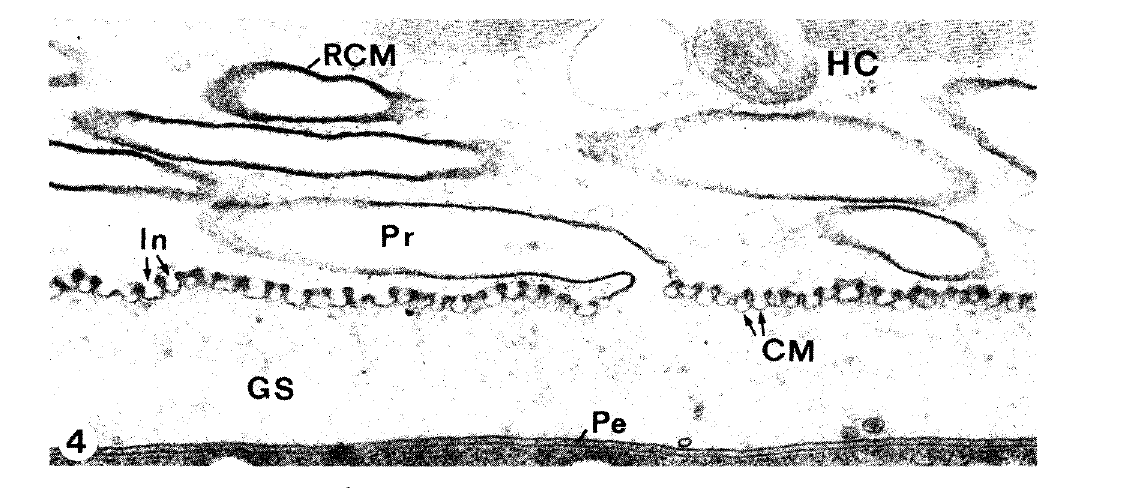
Fig. 4. Vertical section through the cyst wall, showing closely spaced vesicular invaginations (In) of the limiting cyst membrane (CM), which is visualized as a thin line at the bottom of the invaginations. Between the invaginations and on the entire surface of the projections (Pr) the cyst membrane has a thin coating of electron-dense material on its inner surface, both structural entities being referred to collectively as the